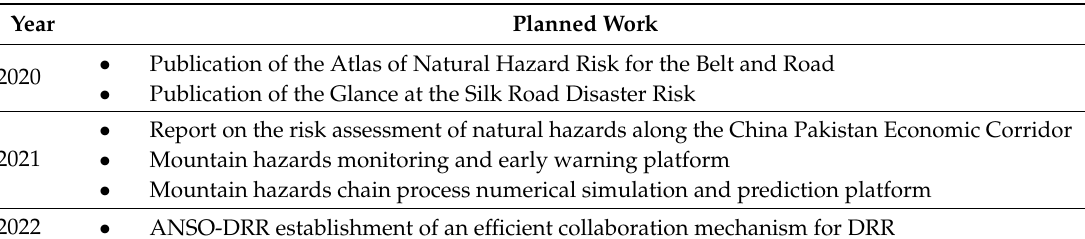
Table 1. Planned work of ANSO-DRR for